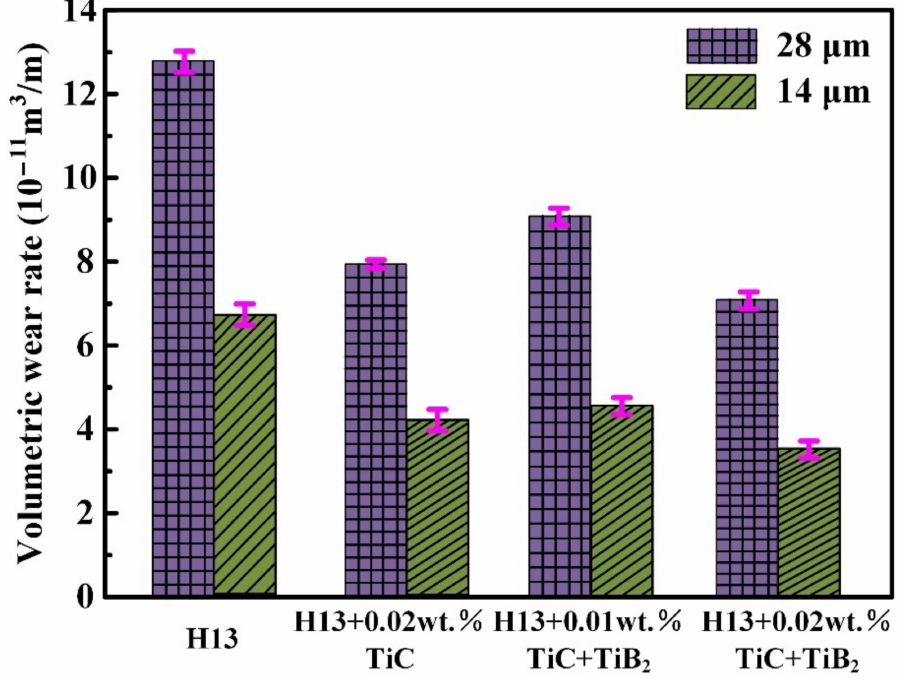
Figure 9. Volumetric wear rate of H13 steels without and with nanoparticles at different sandpaper abrasive particle